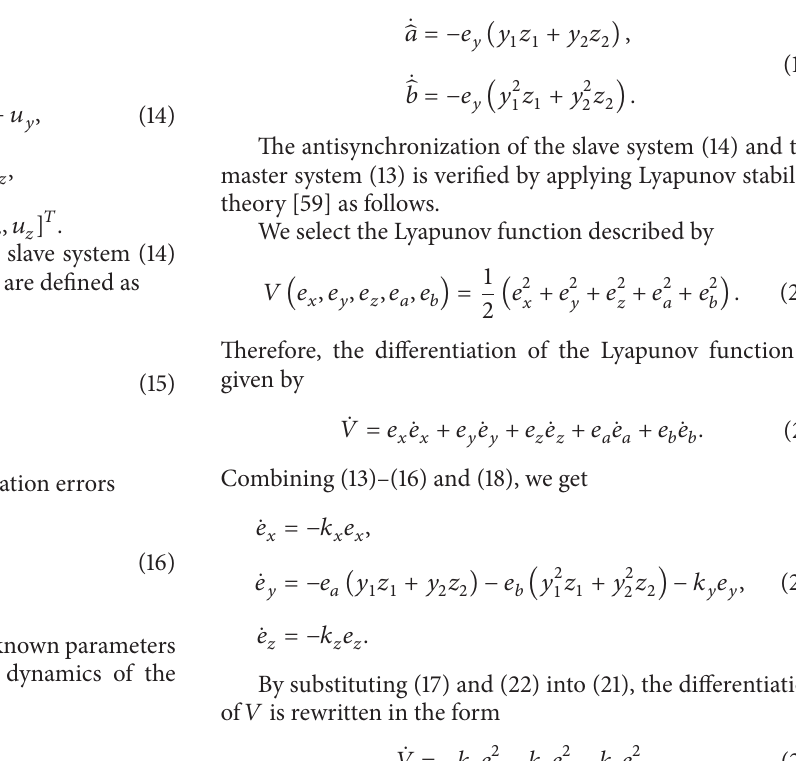
in which three state variables are 𝑥 , 𝑦 , and 𝑧 while 𝑎 and 𝑏 are two unknown